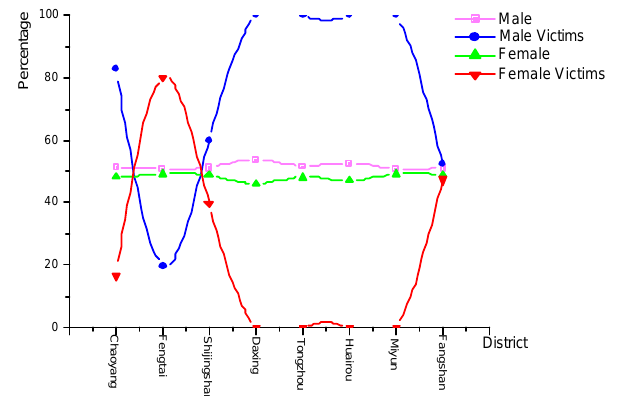
Fig. 9. The gender distribution of population and victims in the eight affected districts.